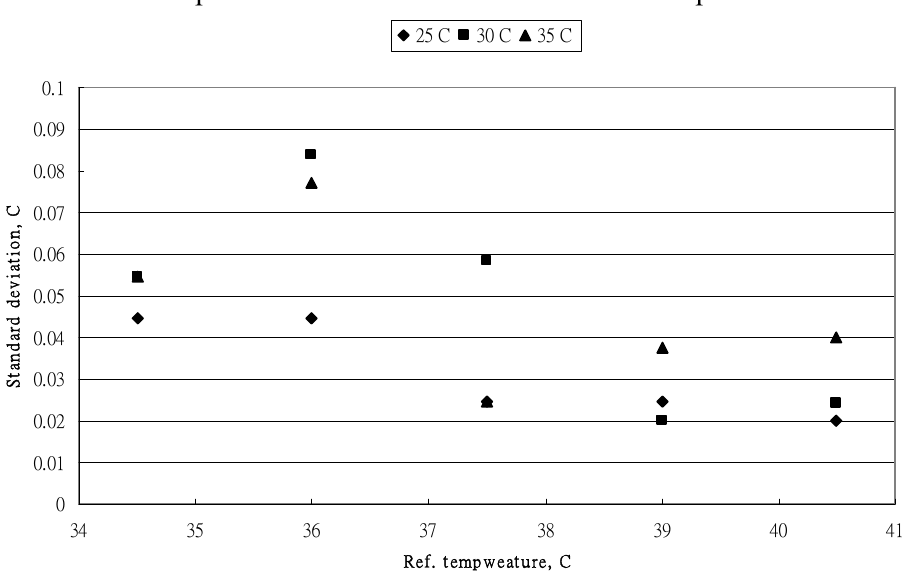
Figure 7. The standard deviation of five measurements of OMRON MC-510 thermometer at different standard temperatures and three leaves of ambient